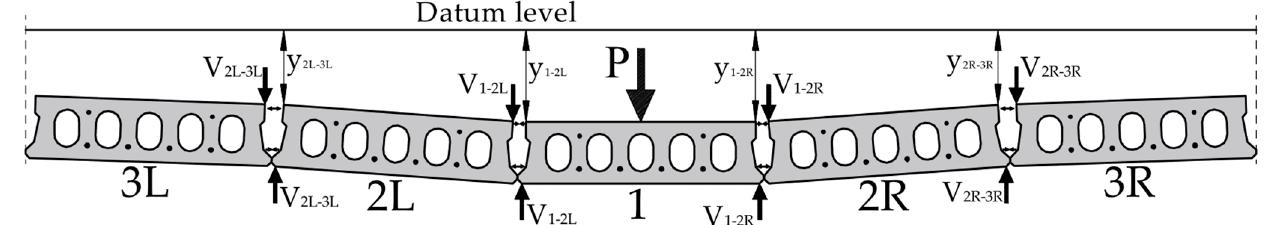
Figure 1. Structural mechanism for lateral load spreading of precast slabs (based on [51]): v i —shear reaction in shear key; y i —displacement at shear key.